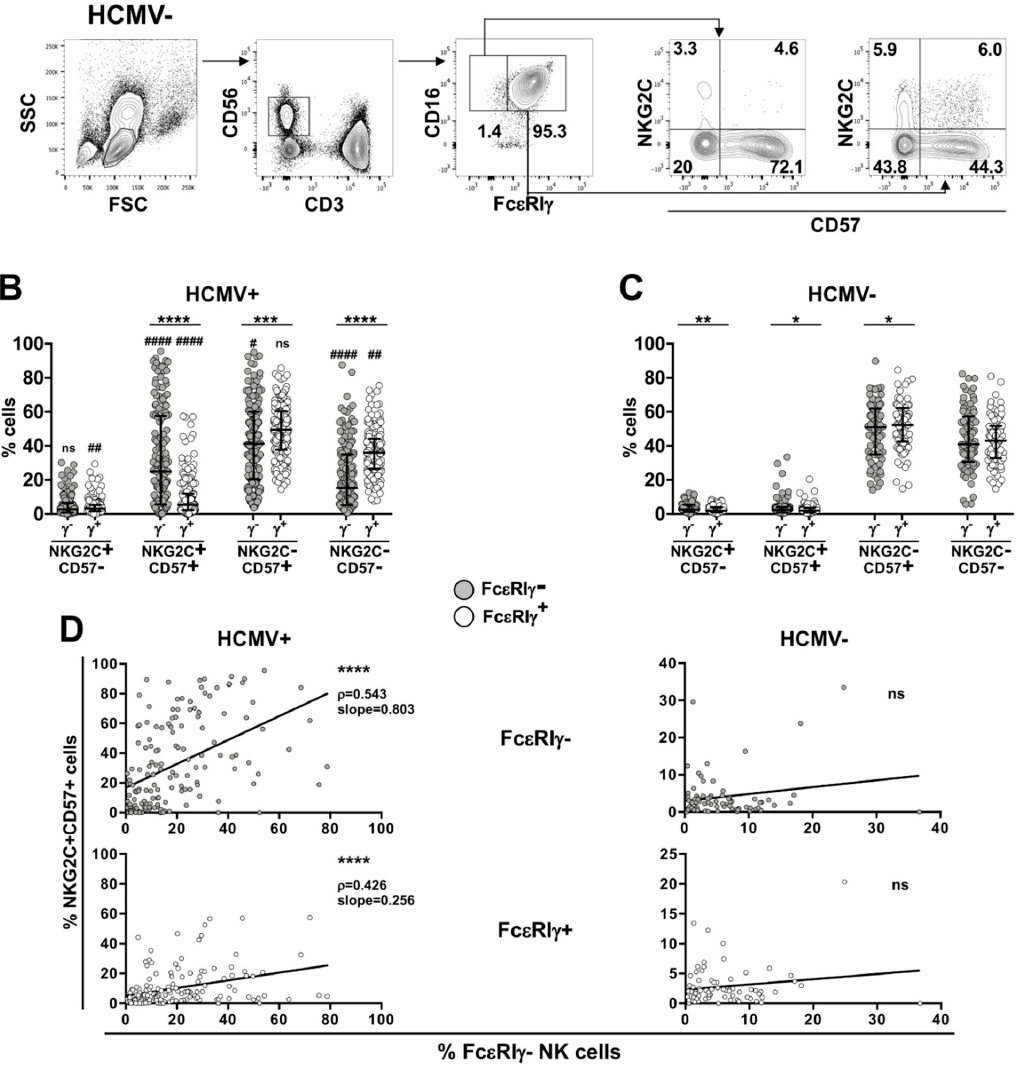
Figure 1. Fc ε RI γ − NKG2C + CD57 + cells markedly expand in HCMV-seropositive individuals and tightly correlate with individual Fc ε RI γ − memory pool size. ( A ) Gating strategy for the identification of peripheral blood Fc ε RI γ − and Fc ε RI γ + CD16 + CD56 dim NK cell subsets. Numbers represent per- centage of gated cells. ( B , C ) Stratification of CD16 + CD56 dim NK cells according to NKG2C and CD57 expression, within Fc ε RI γ − ( γ − , grey) and Fc ε RI γ + ( γ + , empty) cell pools, of 154 HCMV-seropositive (HCMV + ) ( B ) and 75 HCMV-seronegative (HCMV − ) ( C ) healthy individuals. Bars represent median with interquartile range. p values of pairwise comparisons were calculated with Wilcoxon (Fc ε RI γ − vs. Fc ε RI γ + ) and Mann–Whitney (HCMV + vs. HCMV − ) non-parametric tests. (*) symbol indicates statistical comparison with corresponding Fc ε RI γ + subset (Fc ε RI γ − vs. Fc ε RI γ + ): (*) <0.05, (**) <0.005, (***) < 0.0001, (****) < 0.00001; (#) symbol indicates statistical comparison with corresponding subset of HCMV − donors (HCMV + vs. HCMV − ): (#) < 0.05, (##) < 0.005, (####) < 1 × 10 − 7 . ( D ) Correlation between the percentage of Fc ε RI γ − NKG2C + CD57 + (grey, upper panels) or Fc ε RI γ + NKG2C + CD57 + (white, lower panels) subsets with the size of the Fc ε RI γ − memory NK cell pool in HCMV + (left panels) and HCMV − (right panels) individuals. Spearman’s correlation coefficients (r) and curve slopes are reported when 2-tailed p values were significant (<0.05): (****) < 1 × 10 − 7